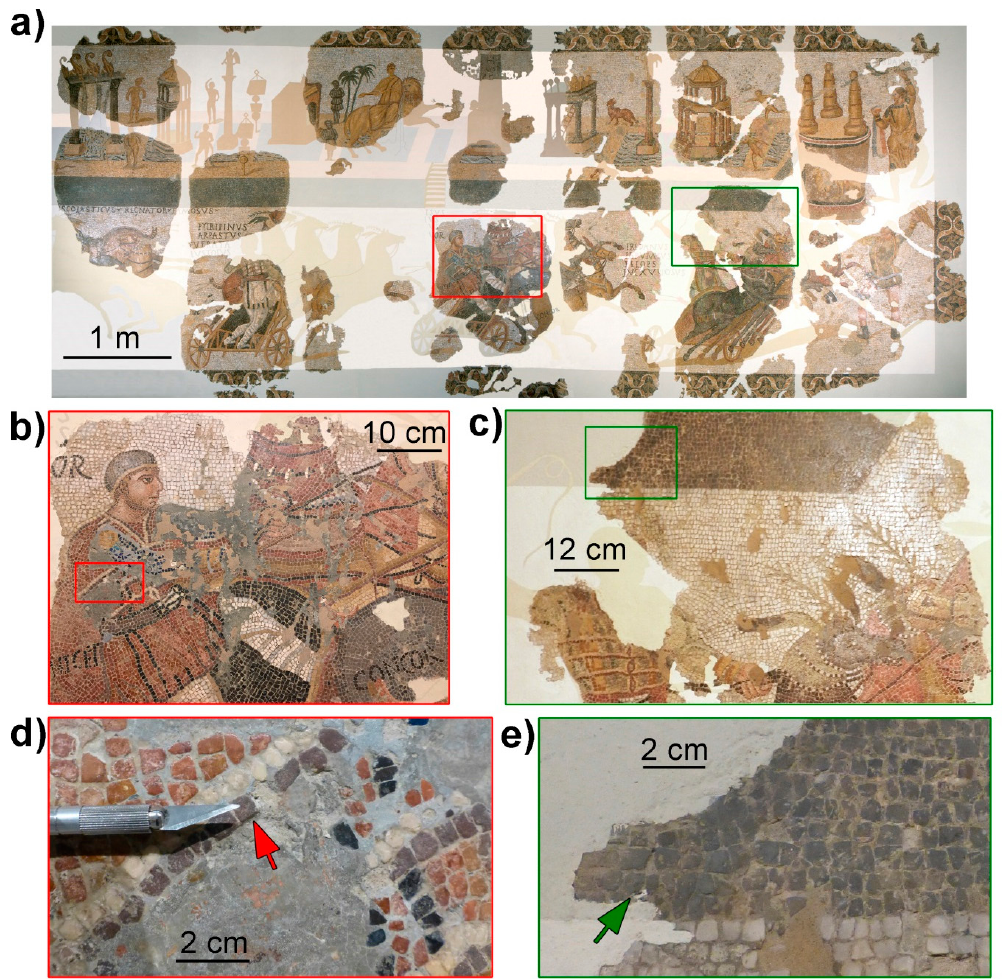
Figure 7. Sampled “circus mosaic” MAC-19004. ( a ) Full view of the mosaic (7.98 m × 3.53 m) including preserved fragments and interpreted parts. Details of ( b ) the central quadriga and ( c ) the spina framework. ( d ) Original location of the sampled dusky red tessella (red arrow). ( e ) Original location of the sampled greenish gray tessella.